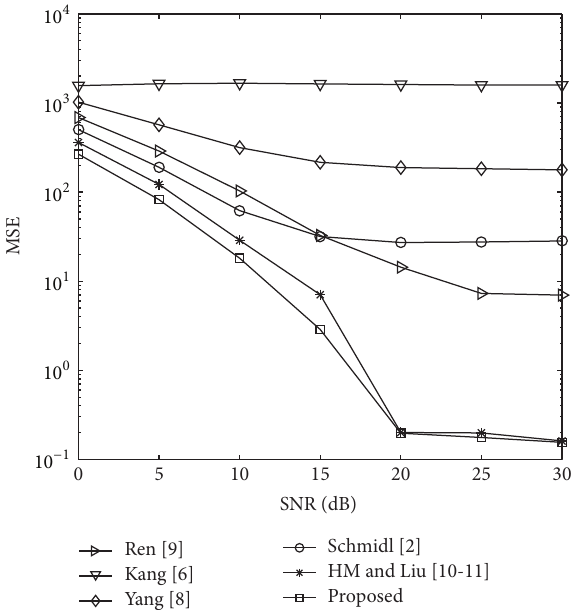
Figure 3: Timing MSE versusSNR for six methods in SUI-1 channel ( 𝑁 = 64 and 𝐺 = 8 ).